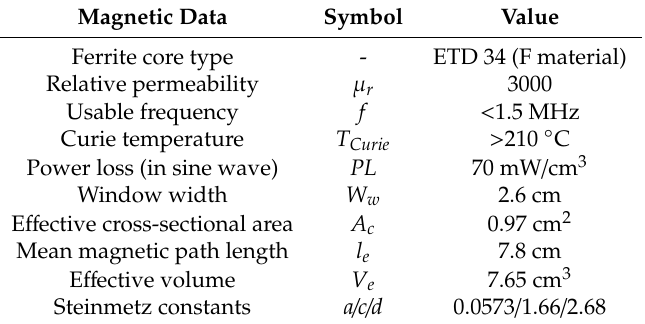
Table 2. Magnetic data for transformer